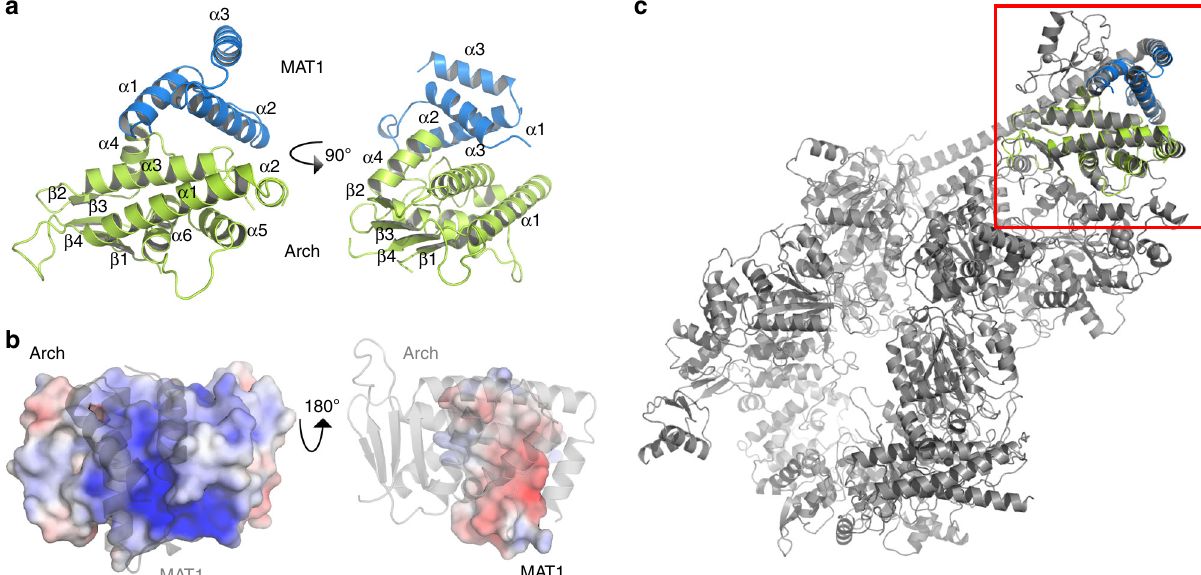
Fig. 2 Structure of the human MAT1 – Arch domain complex. a Overall fold of the MAT1 (blue) and Arch domain (green) complex in two orientations rotated 90° around the y -axis. The secondary structure elements are labeled. b Molecular surface representation with electrostatic potential mapping of either the Arch (left) domain or MAT1 (right). Blue denotes positively charged regions and red negatively charged regions. The surface was generated and plotted using the apbs plugin of pymol. The borders for plotting the potential were set to − 6 for negative charge and + 6 for positive charge. The respective binding partner is shown in cartoon representation (gray, 50% transparency). c Overall structure of TFIIH (pdb code 6nmi) in cartoon representation. The red square shows the superposition of our human Arch/MAT1 structure with TFIIH (cartoon representation, color coding as in A, core TFIIH is depicted in